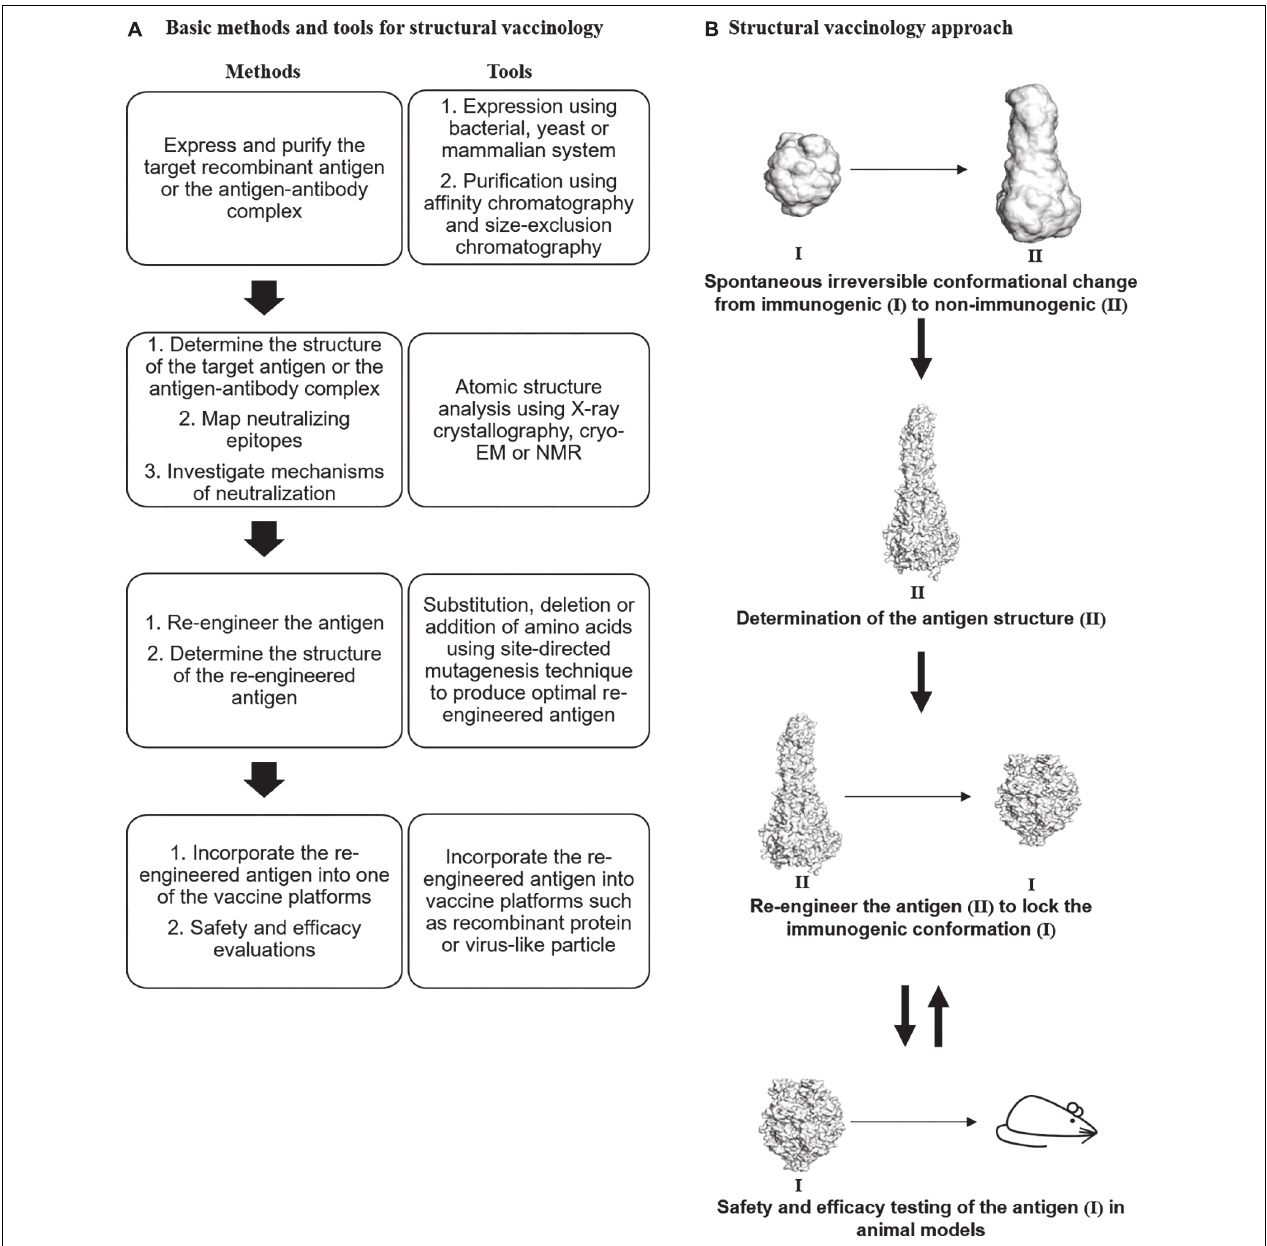
FIGURE 1 | Structural vaccinology for vaccine design. (A) Basic methods and tools for structural vaccinology. (B) Irreversible conformational change (immunogenic to non-immunogenic) of viral antigens occurred spontaneously during recombinant antigen expression. To overcome this problem, the three-dimensional structure of the antigen (II) will be determined using structural biology techniques such as X-ray crystallography, cryo-electron microscopy (cryo-EM), and nuclear magnetic resonance (NMR). Based on the structure, the antigen will be re-engineered to produce an optimal antigen adopting a specific immunogenic conformation (I). Next, the re-engineered antigen could be incorporated into one of the vaccine platforms such as the recombinant protein vaccine platform. Thereafter, the safety and efficacy of the candidate vaccine should be tested in animal models. The antigen could be re-designed based on the animal testing evaluations to improve its immunogenicity and efficacy. RSV F glycoprotein was used as an illustrative example. PDB IDs: 4MMU and